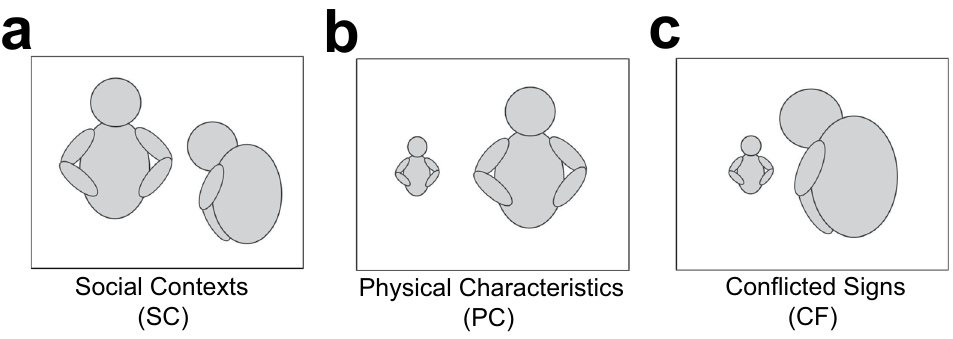
Figure 1. Social rank recognition test. ( a – c ) Examples of images with body languages/gestures as social contexts ( a ; SC), physical characteristics ( b ; PC), and conflicts between them ( c ; CF), used in the test.